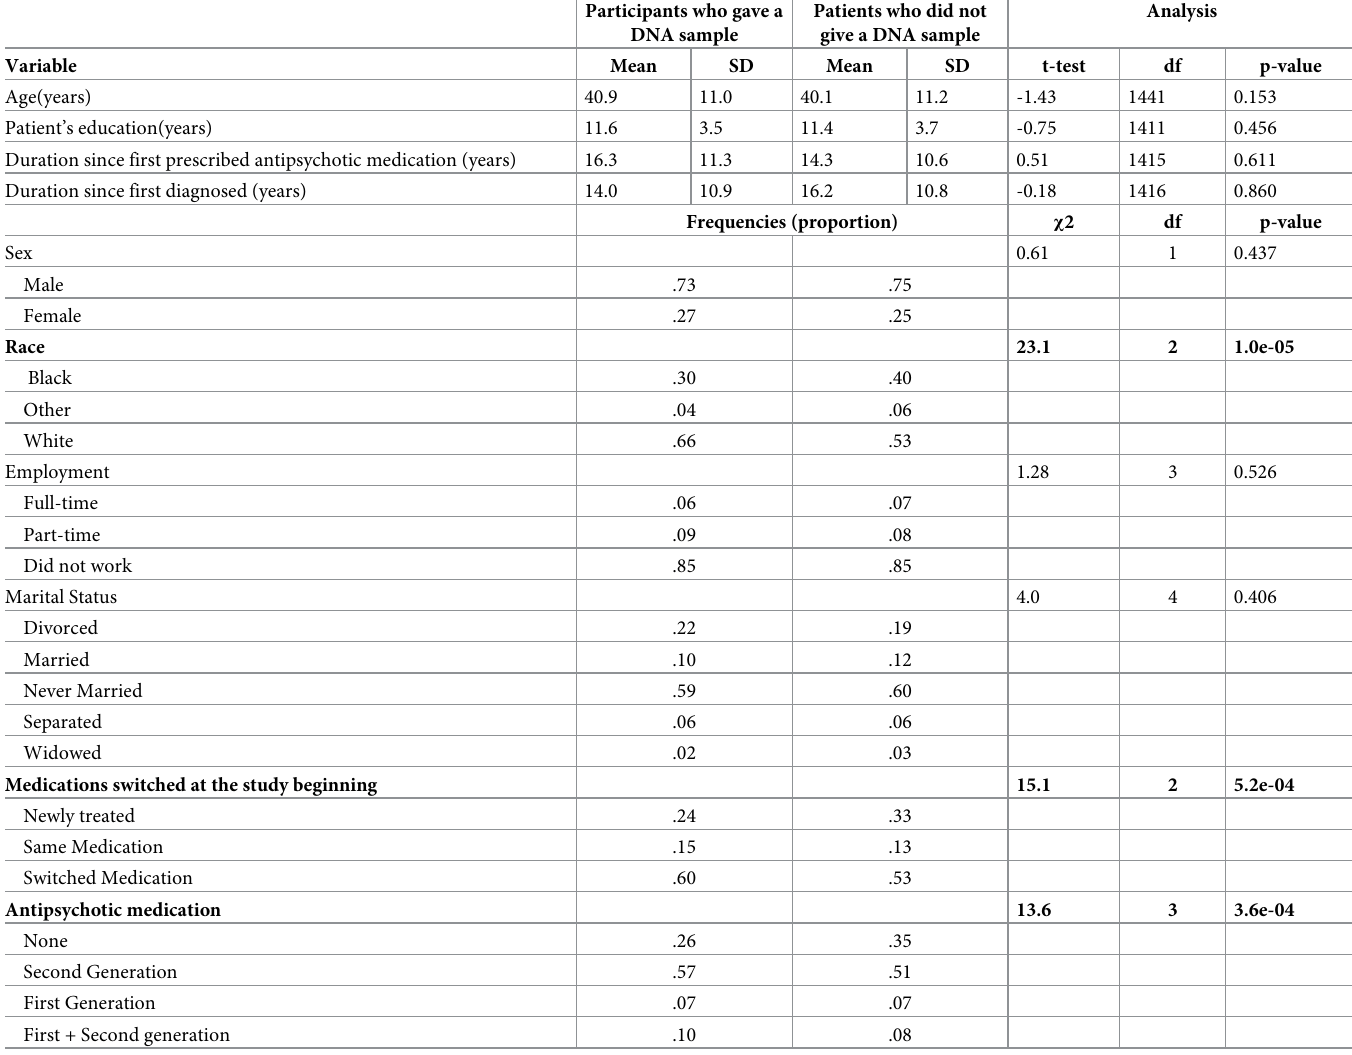
Table 2. Socio-demographic characteristics by genetic sub-study